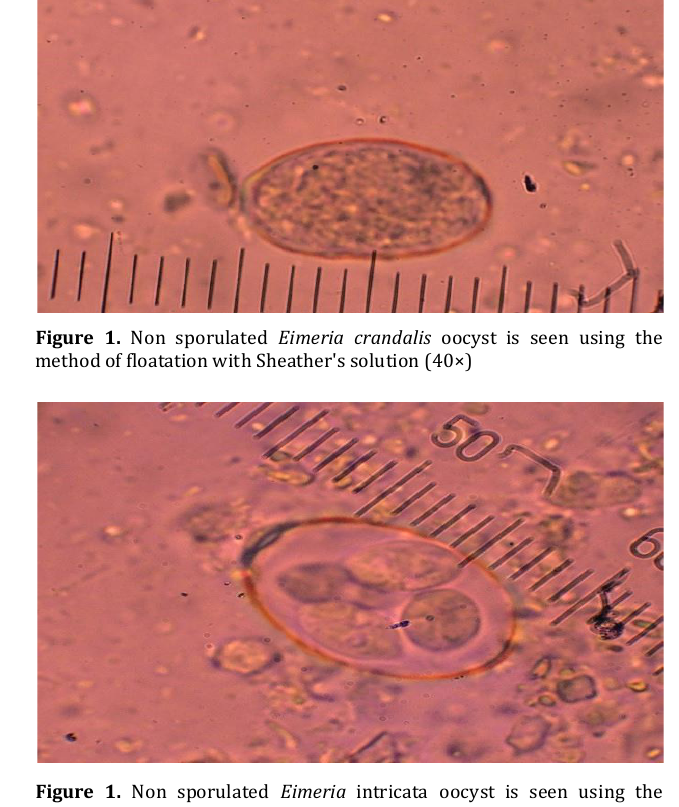
Table 3. Rate of infection by Eimeria spp. in fallown deers ( Dama dama ) based on area of study